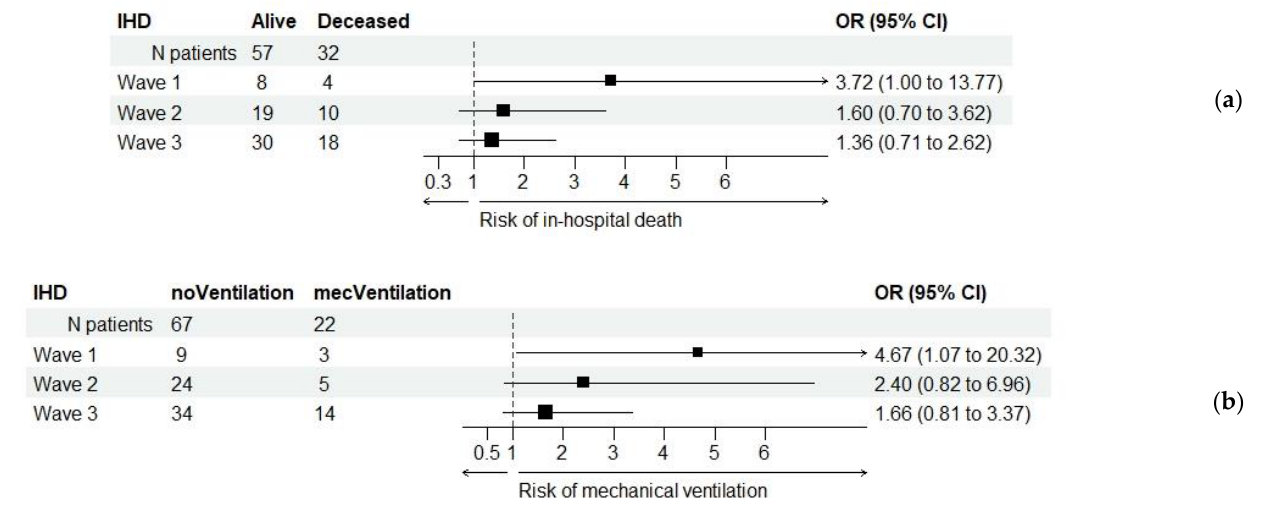
Figure 3. Relationship between ischemic heart disease (IHD) and the primary and secondary out- comes across the three waves: ( a ) odds ratio (OR) values for in-hospital death; ( b ) odds ratio (OR)